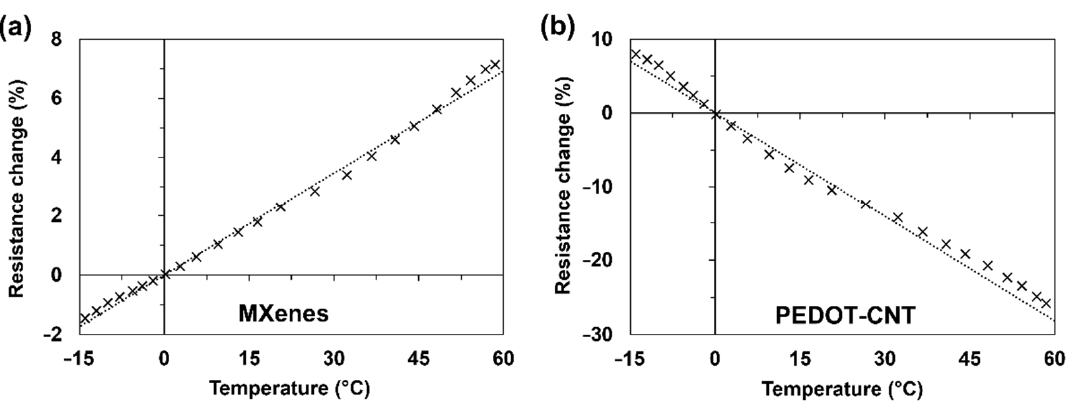
Figure 4. Electrical resistance changes under the ambient temperature of: ( a ) MXene and ( b ) PEDOT- CNT coatings.